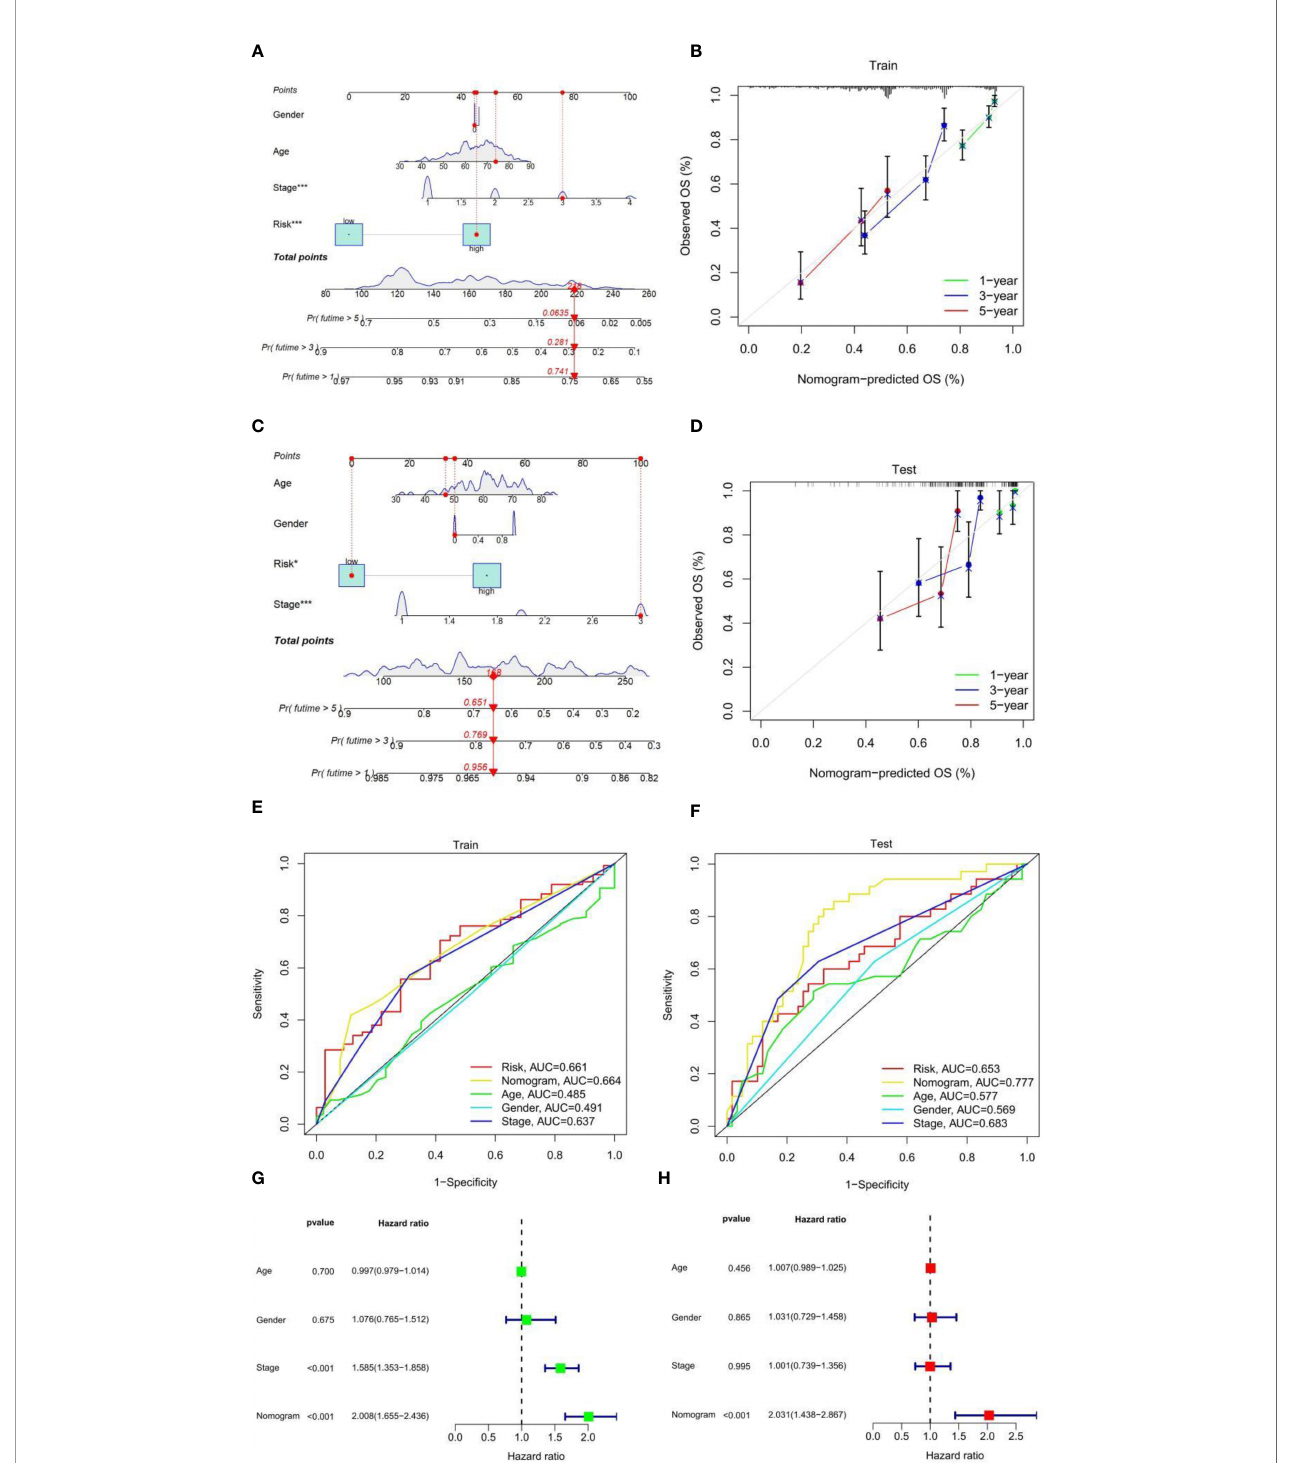
FIGURE 3 | (A) Nomogram to predict 1-, 3-, and 5-year OS in the TCGA-LUAD cohort. (B) Calibration plot to assess the accuracy of a nomogram to predict 1-, 3-, and 5-year OS in the TCGA-LUAD cohort. (C) Nomogram to predict 1-, 3-, and 5-year OS in the GEO-LUAD cohort. (D) Calibration plot to assess the accuracy of a nomogram to predict 1-, 3-, and 5-year OS in the GEO-LUAD cohort. (E) ROC curves of risk score and clinical characteristics in the TCGA-LUAD cohort. (F) ROC curves of risk score and clinical characteristics in the GEO-LUAD cohort. (G) Univariate Cox analysis. (H) Multivariate Cox